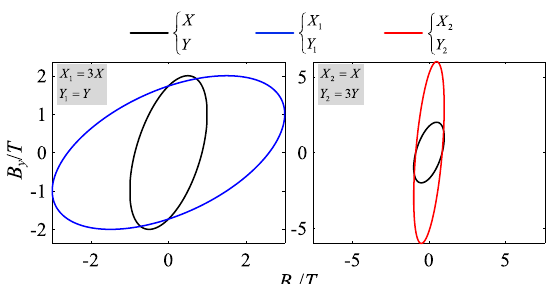
Fig. 5 Lissajous figures at different